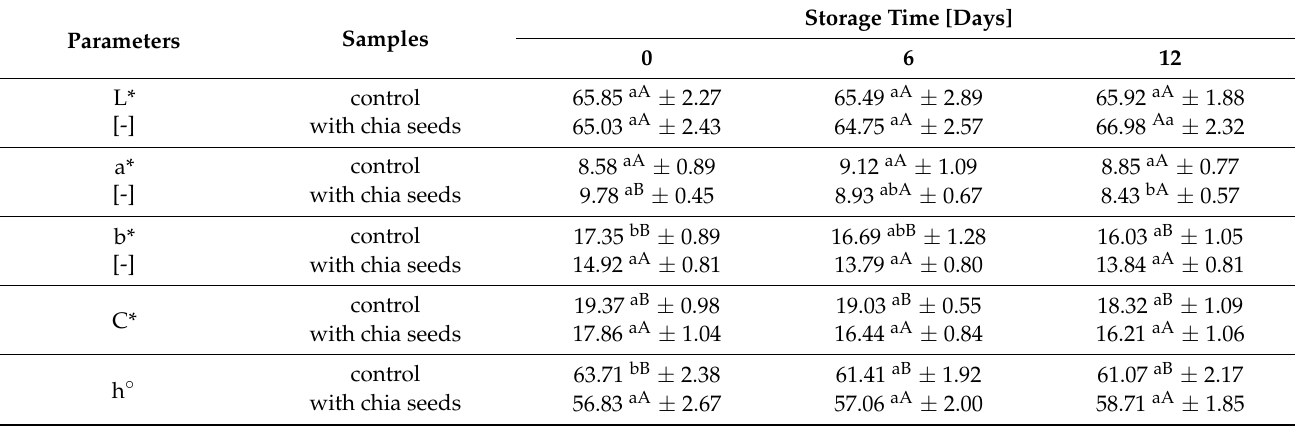
Table 2. Effect of chia seeds and storage time on the colour parameters on the cross section of pork patties (mean ± SD). Parameters